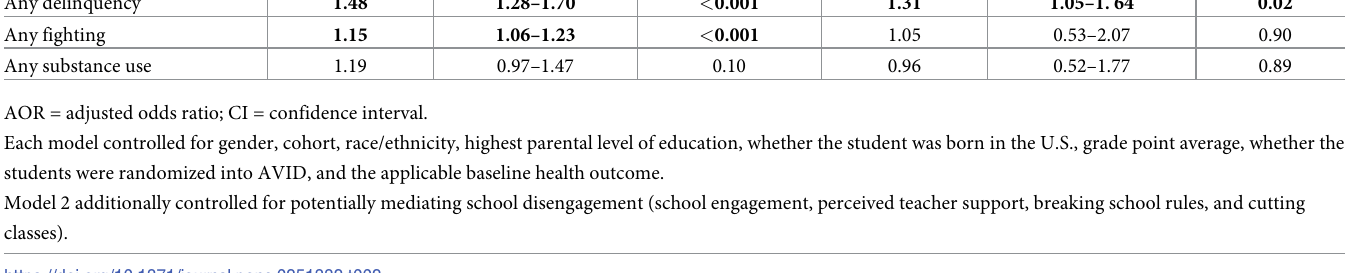
Table 2. Associations between gender stigma awareness and adolescent health with and without adjusting for potential mediating school-related factors.